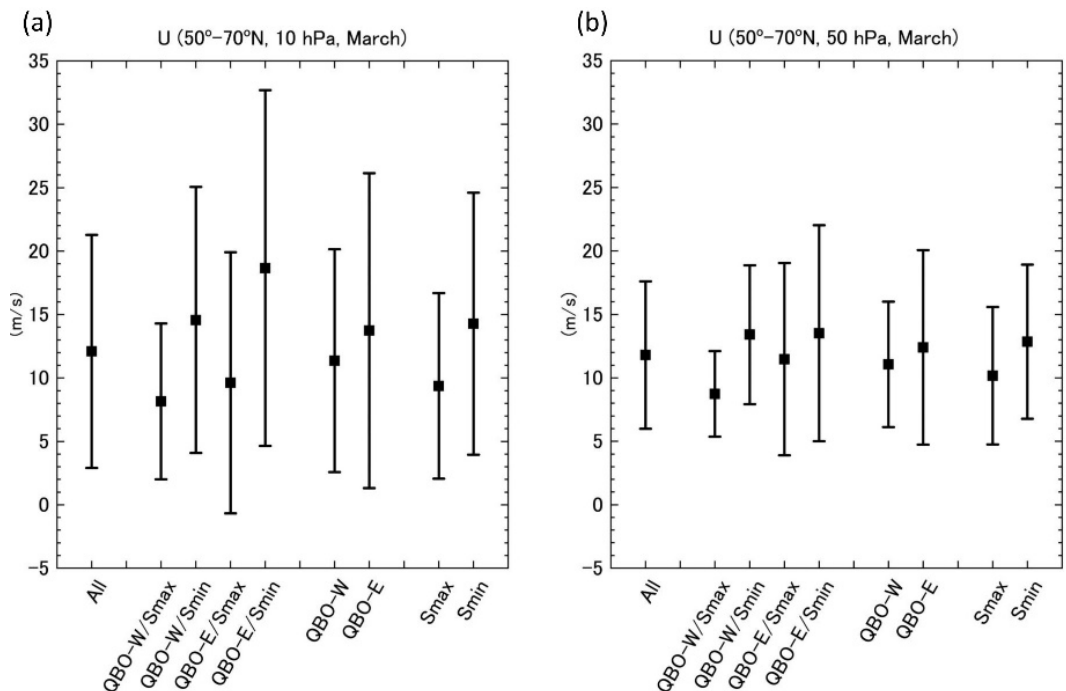
Figure 4. Monthly mean, zonal mean zonal wind averaged over 50 − 70 N at 10 hPa ( a ) and 50 hPa ( b ) in March from ERA-Interim data with units of m/s. The average values for all the years 1980–2011, the four QBO/solar activity phase groups, the two QBO phase groups, and the two solar activity phase groups are indicated by squares with the standard